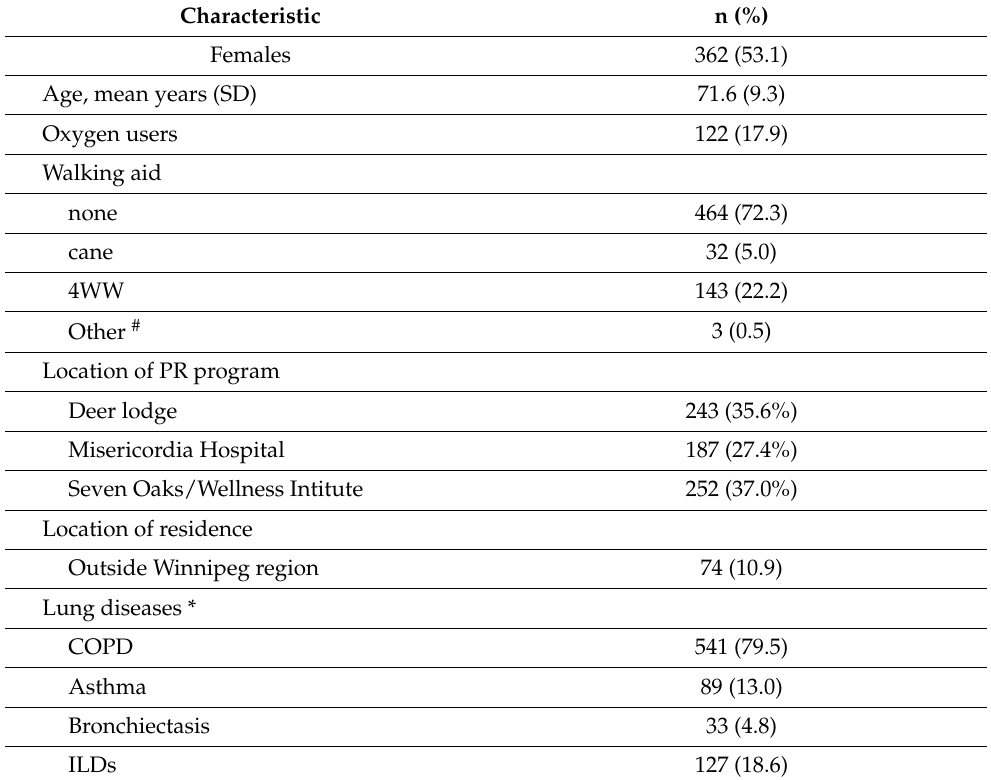
Table 1. Characteristics of the participants who completed the pulmonary rehabilitation (PR) program 2016–2019 (n =